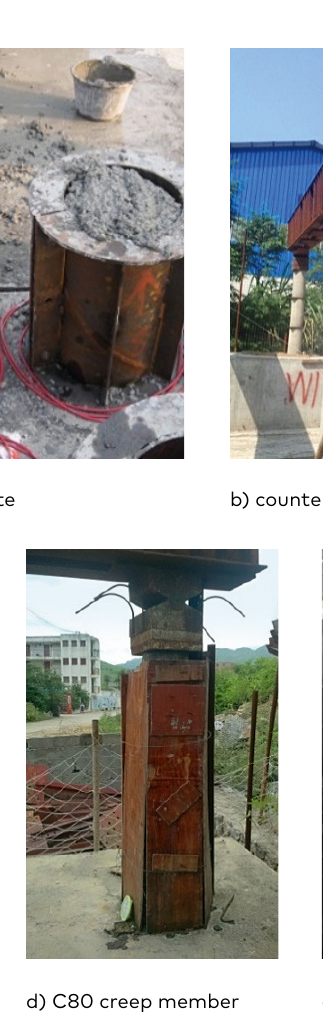
Figure 3. General view of the experiment